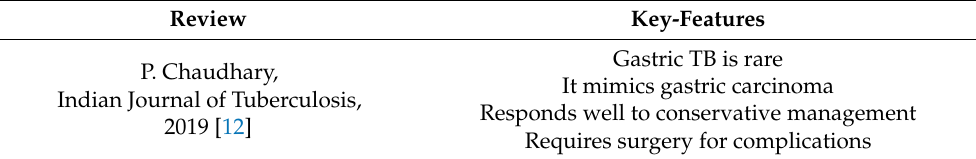
Table 3. Gastroduodenal tuberculosis: examples of literature studies and their key